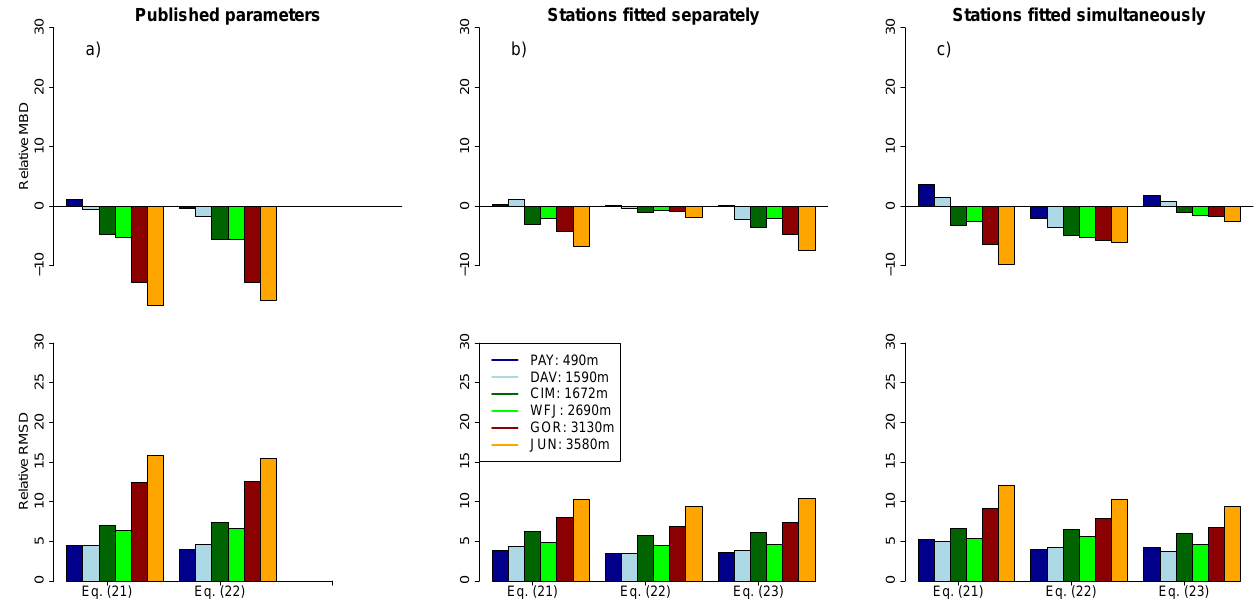
Fig. 8. MBD and RMSD for the LDR parameterizations using (a) the published parameter values by Pirazzini et al. (2000), (b) the parameter values when fitting the parameterizations to each station separately and (c) when fitting all stations together simultaneously. Clear-sky emissivity is estimated based on the Konzelmann et al. (1994) parameterization, using the parameters fitted for all stations simultaneously.